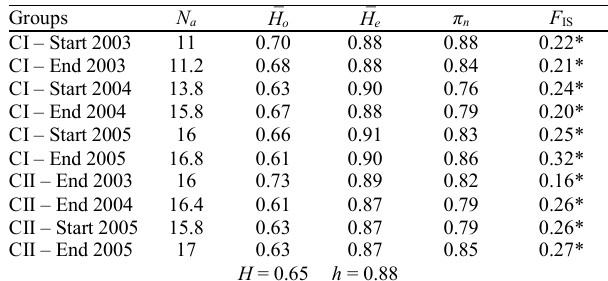
Table 5. Index of intrapopulational genetic diversity obtained based on microsatellite marker for the groups of Leporinus elongatus from the fish passage ladders of HEPs Canoas I and Canoas II- Paranapanema River. N : mean number of alleles a per locus; H : mean heterozygosity observed; H : mean o e heterozygosity expected; H : total heterozygosity; h : total mean heterozygosity expected; π : mean gene diversity over n all loci; F : Fixation index intrapopulational; * Statistically IS significant value to 5%. Start: collected from January to March; End: collected from October to